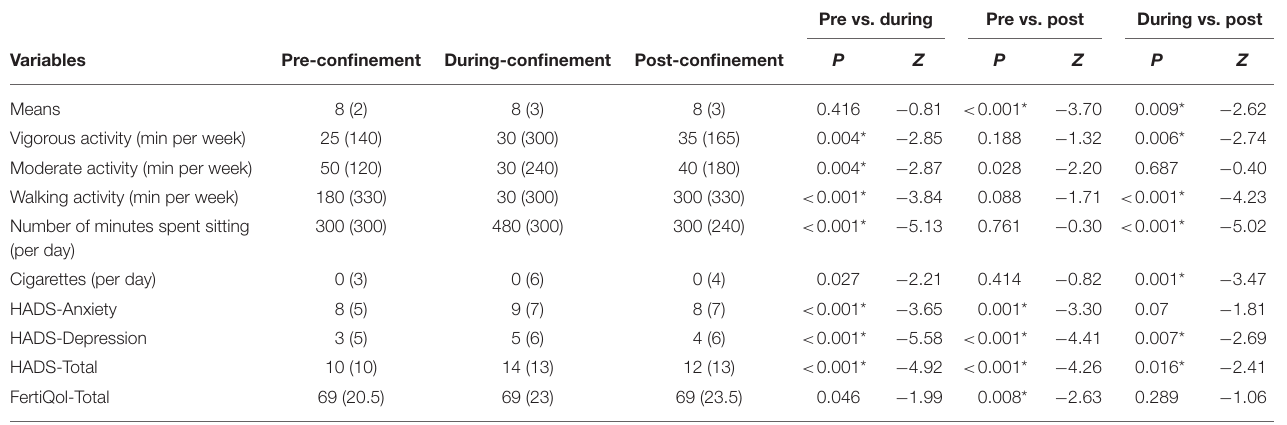
Pre vs. during Pre vs. post During vs. post